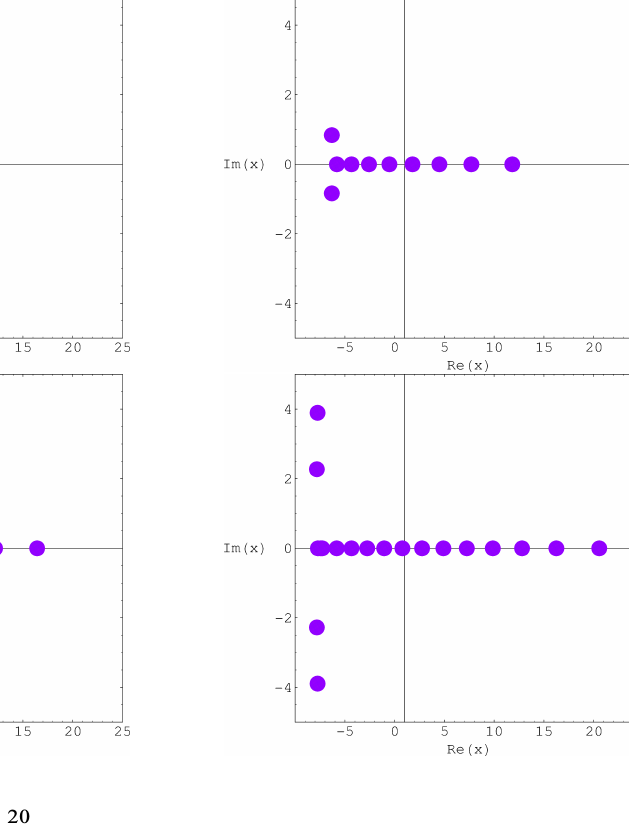
Fig. 4. Stacks of zeros of B n .x;(cid:21)/;1 (cid:20) n (cid:20) 20